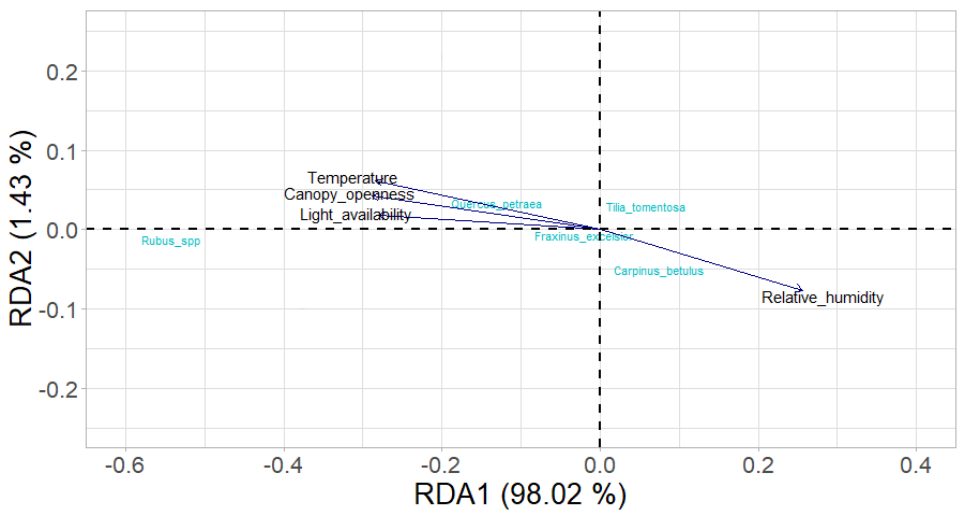
Figure 3. Redundancy analysis (RDA) of the presence of eight-year-old sessile oak seedlings and major competing species in relation to basic environmental factors (available light, air temperature, and relative humidity) and canopy openness .